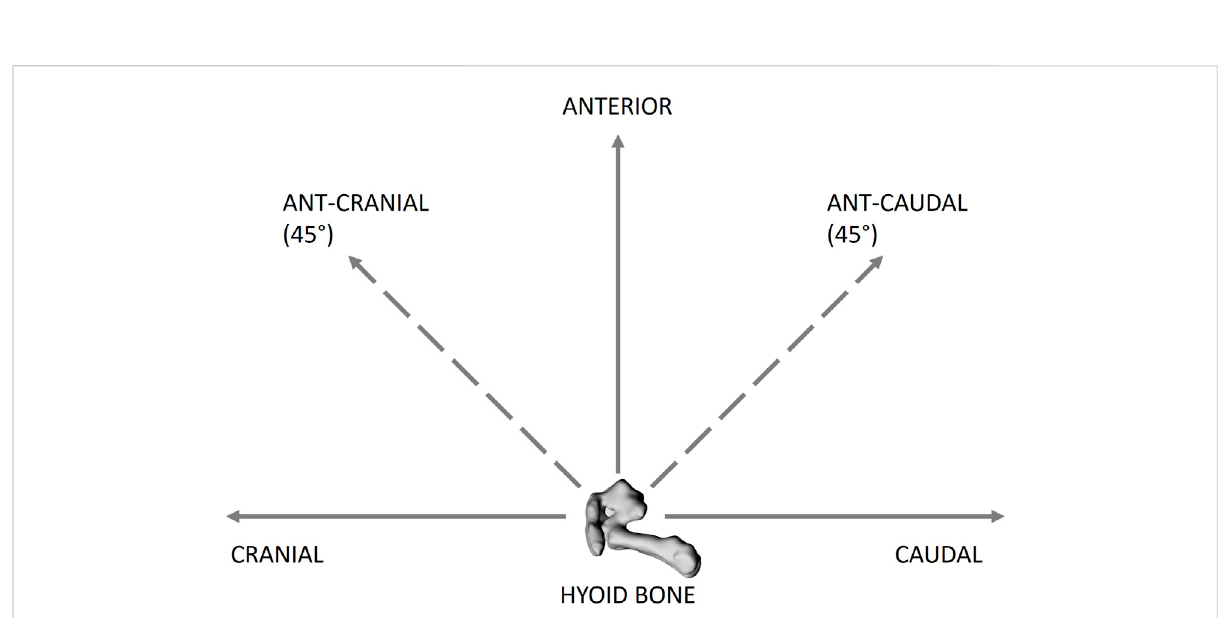
FIGURE 2 Schematic of the hyoid bone (lateral view) showing the different directions of hyoid bone displacement applied, including cranial, caudal, anterior, anterior-caudal45 ° (ant-caudal) andanterior-cranial45(ant-cranial). Thehyoidbone wasdisplaced from0to5 mmat1 mmincrements in all the